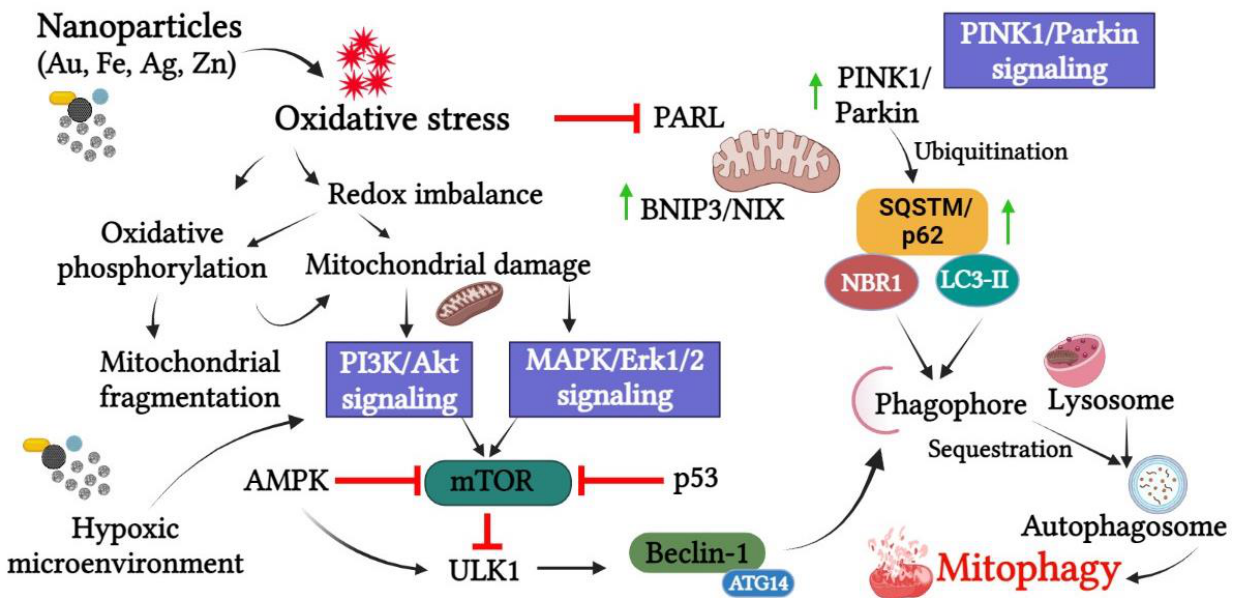
Figure 3. Major molecular pathways implicated in mitophagy that is induced by